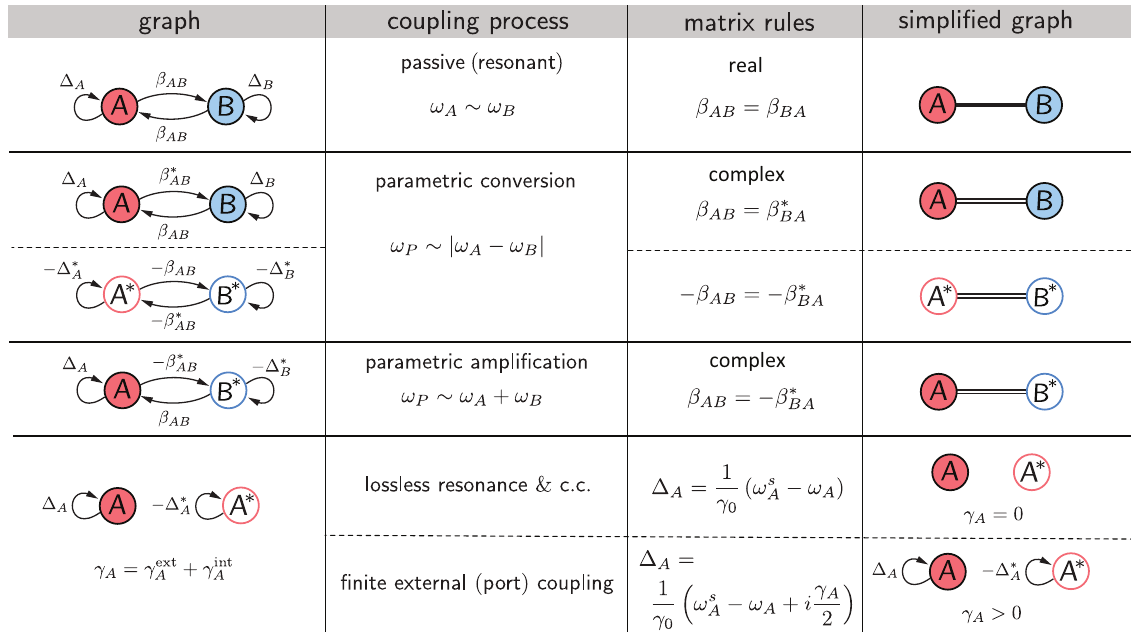
FIG. 1. Rules for writing the equation-of-motion matrix elements of a system from its graph representation. Left column: graph primitives using the notation of Ref. [18]; second column: corresponding coupling process; third column: matrix elements and their conjugation relations; right column: abbreviated notation used in this